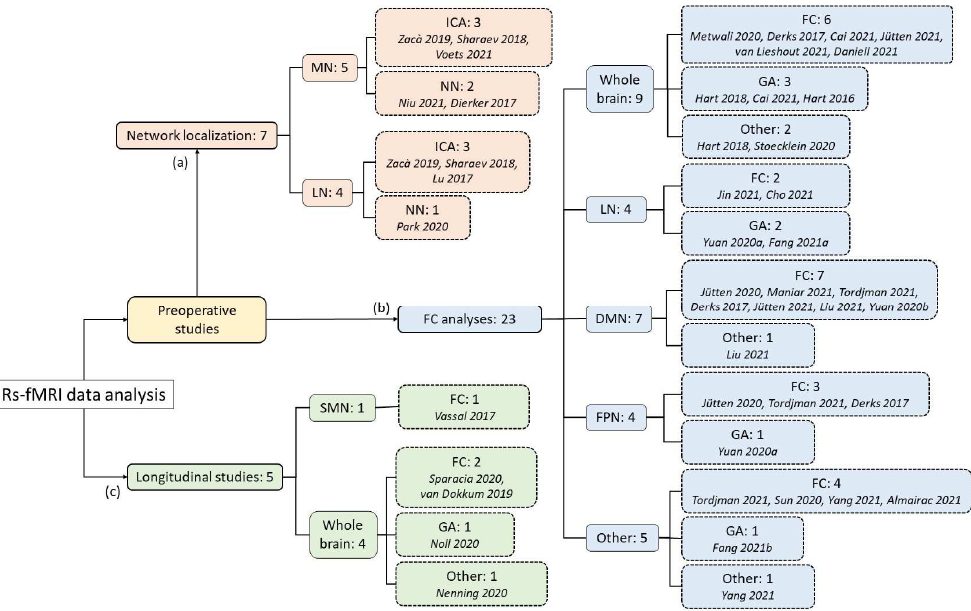
Figure 1. Diagram representing the number of papers reviewed for the present work, subdivided on the basis of their goal, functional network studied, and analytical method used, reaching a total of 1452 patients examined [22–55]. The references are reported in order of citation. Certain studies explored different aspects; therefore, the sum of subgroups may be greater than the actual number